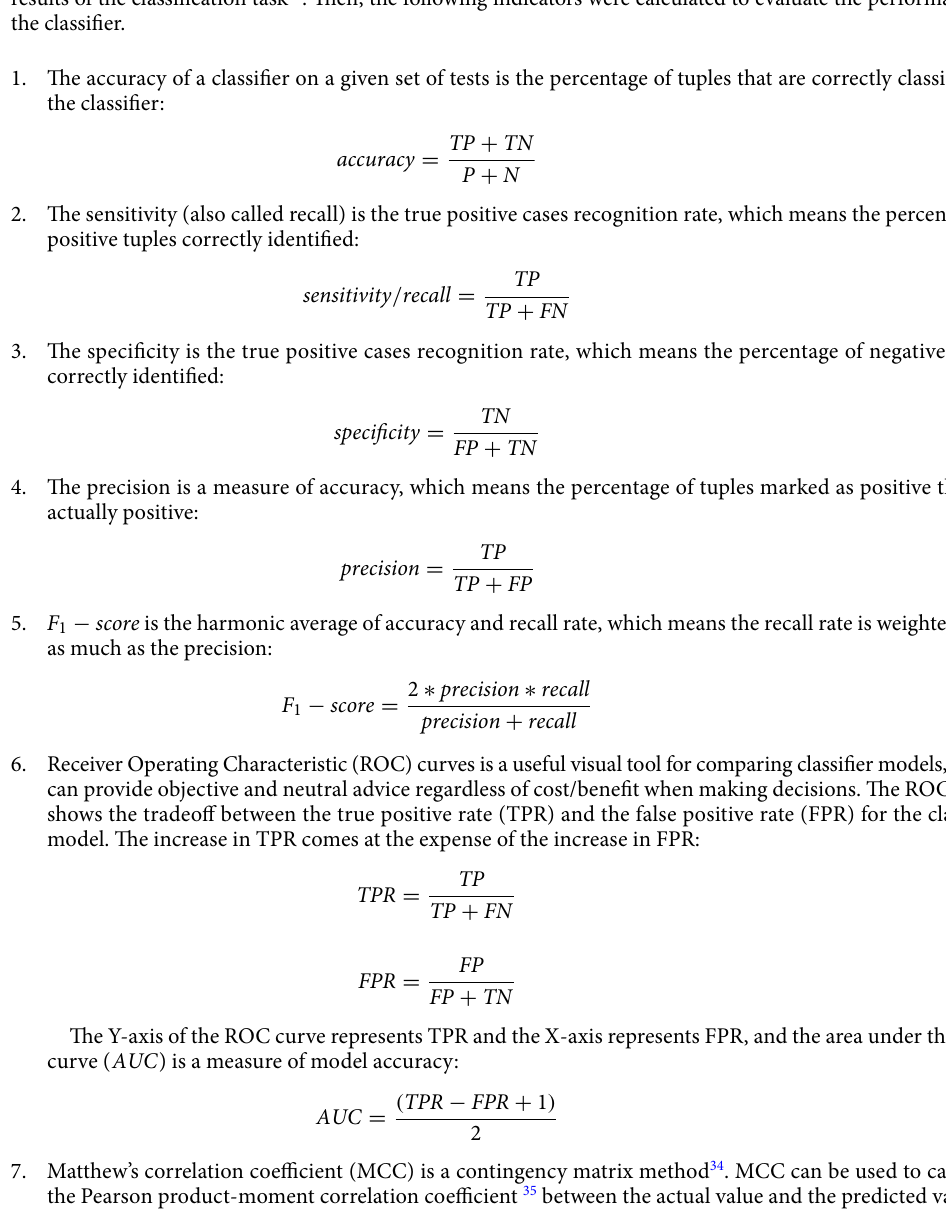
table called confusion matrix m results of the classification task 34 . Then, the following indicators were calculated to evaluate the performance of the